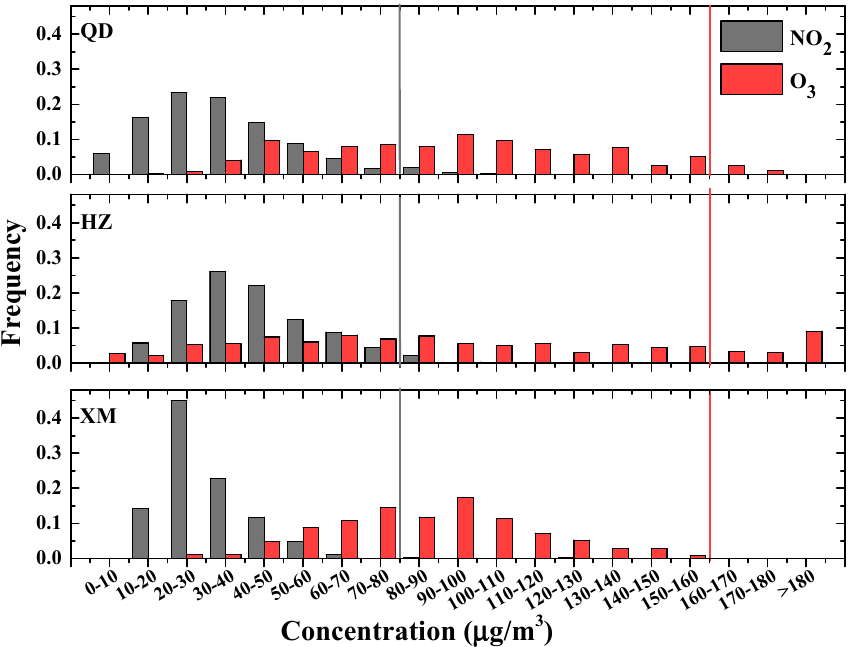
Figure 5. Frequency distributions of daily SO 2 and CO in Qingdao (QD), Hangzhou (HZ) and Xiamen (XM) during 2018. The CAAQS Grade II of daily average for SO 2 and CO are plotted as solid lines.